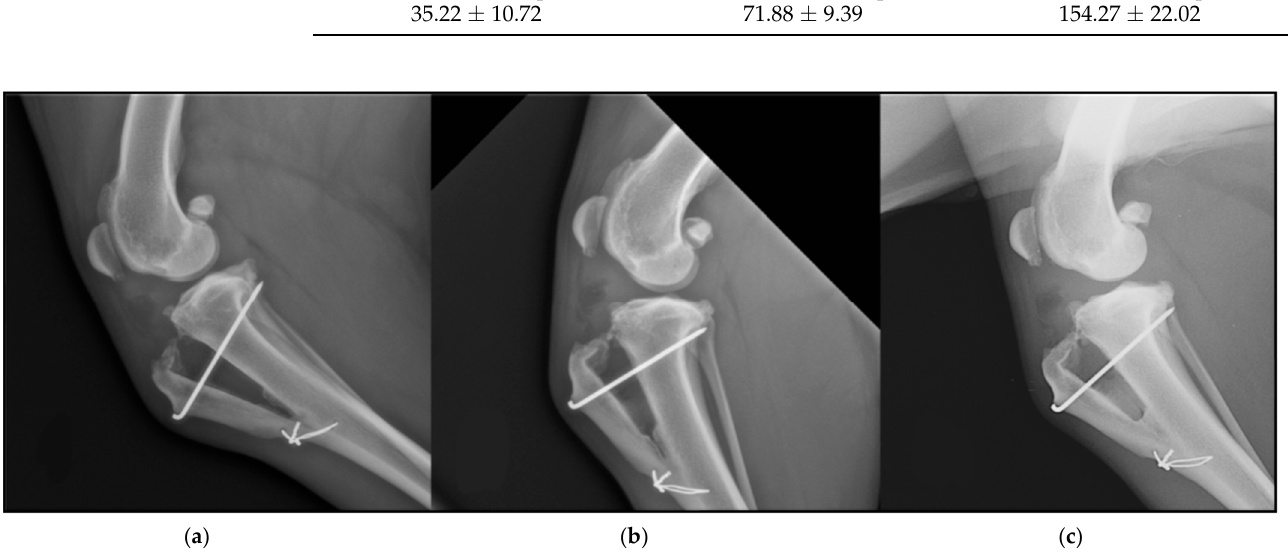
Figure 5. Different times of ossification in a dog. ( a ) Ossification in the first follow ‐ up. ( b ) Ossification in the second follow ‐ up. ( c ) Ossification in the third follow ‐ up.